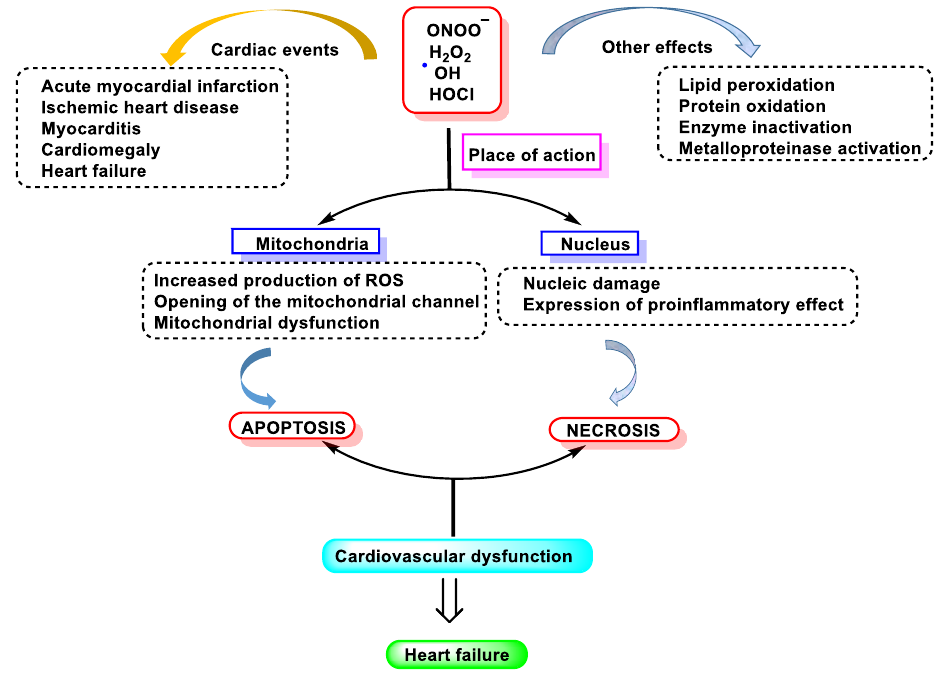
Figure 50. Free radical-induced damage to the cardiovascular